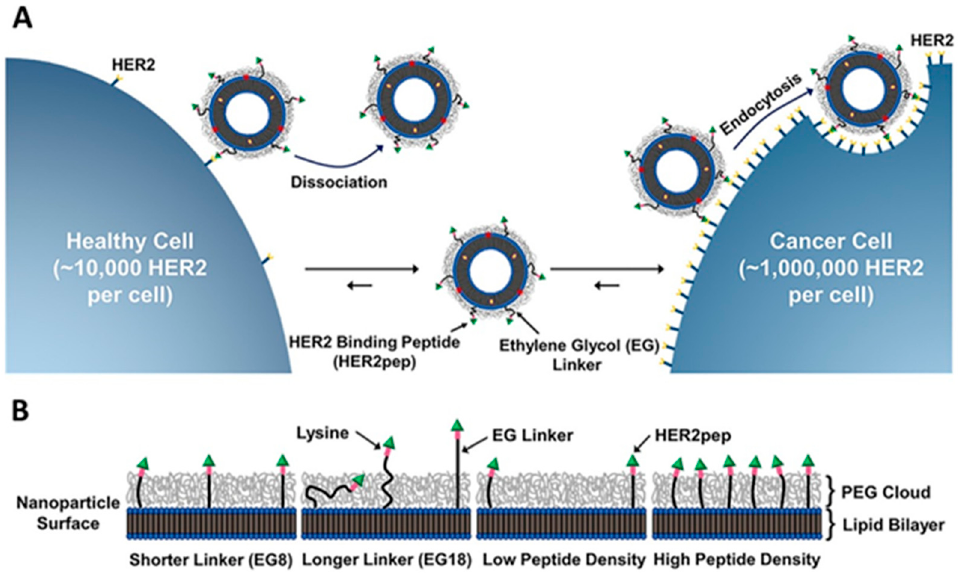
Figure 1. Schematic representation of specific targeted drug delivery strategy of Dox prodrug-loaded TNPHER2pep for HER2 overexpressing breast cancer cells. ( A ) Dissociation and association of expression of HER2 on epithelial cells within breast cancer lesions are many folds higher than that on healthy epithelial cells. On HER2 overexpressing breast cancer cells, TNPHER2pep liposome undergoes endocytosis ( B ) density of peptide and length of EG linker are designed, synthesized, and applied using both in vitro and in vivo methods to increase liposome cellular uptake in breast cancer cells. Reproduced with permission from ref. [86] Copyright © 2020,